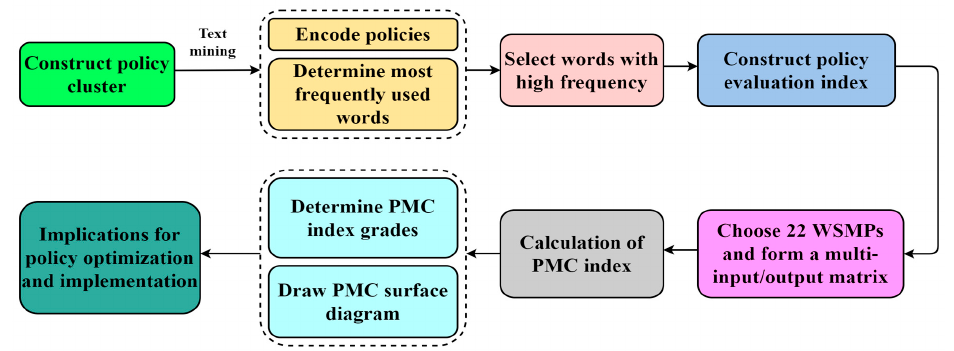
Figure 2. Construction framework for the PMC index model.